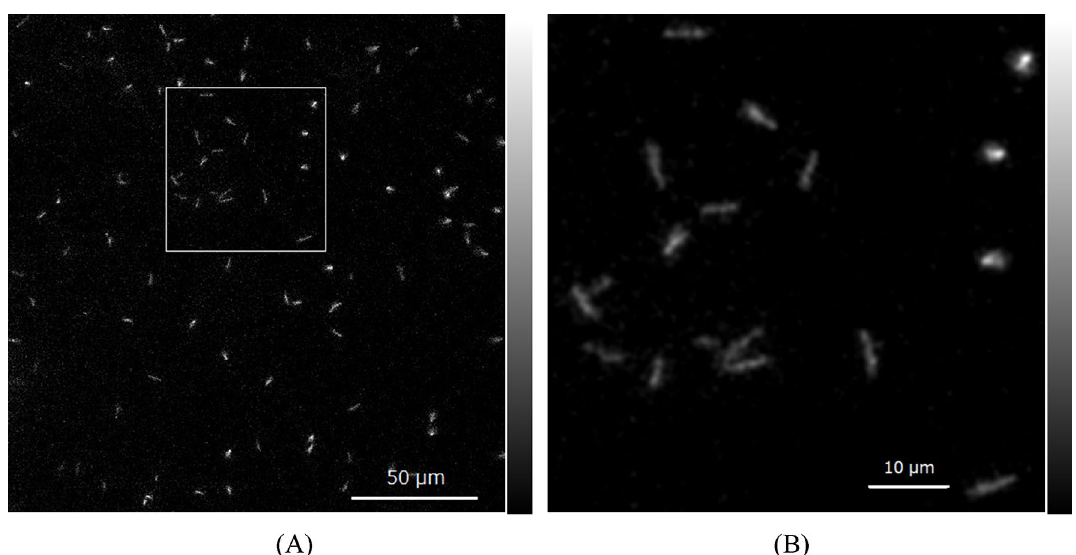
Figure 4. Image of alpha particles in GAGG plate measured by the developed system for LE alpha source ( A ) and magnified image ( B ) of area in